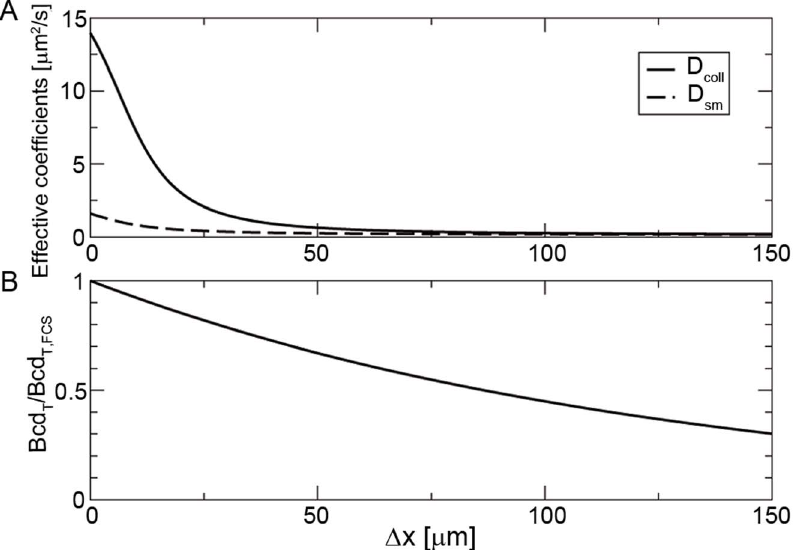
Figure 5. Effective diffusion coefficients and Bicoid concentration as functions of position along the embryo. Top: Effective diffusion coefficients, D coll with solid lines, D sm with dashed lines, as functions of the distance to the location where FCS and FRAP experiments were performed, D x , for a uniform concentration of binding sites consistent with its estimated cytoplasmic value during interphase ( S T = Bcd c , FCS and for a total concentration of Bcd that decreases exponentially with distance with a 125 m m decaying length. Bottom: corresponding exponential profile of total Bcd.